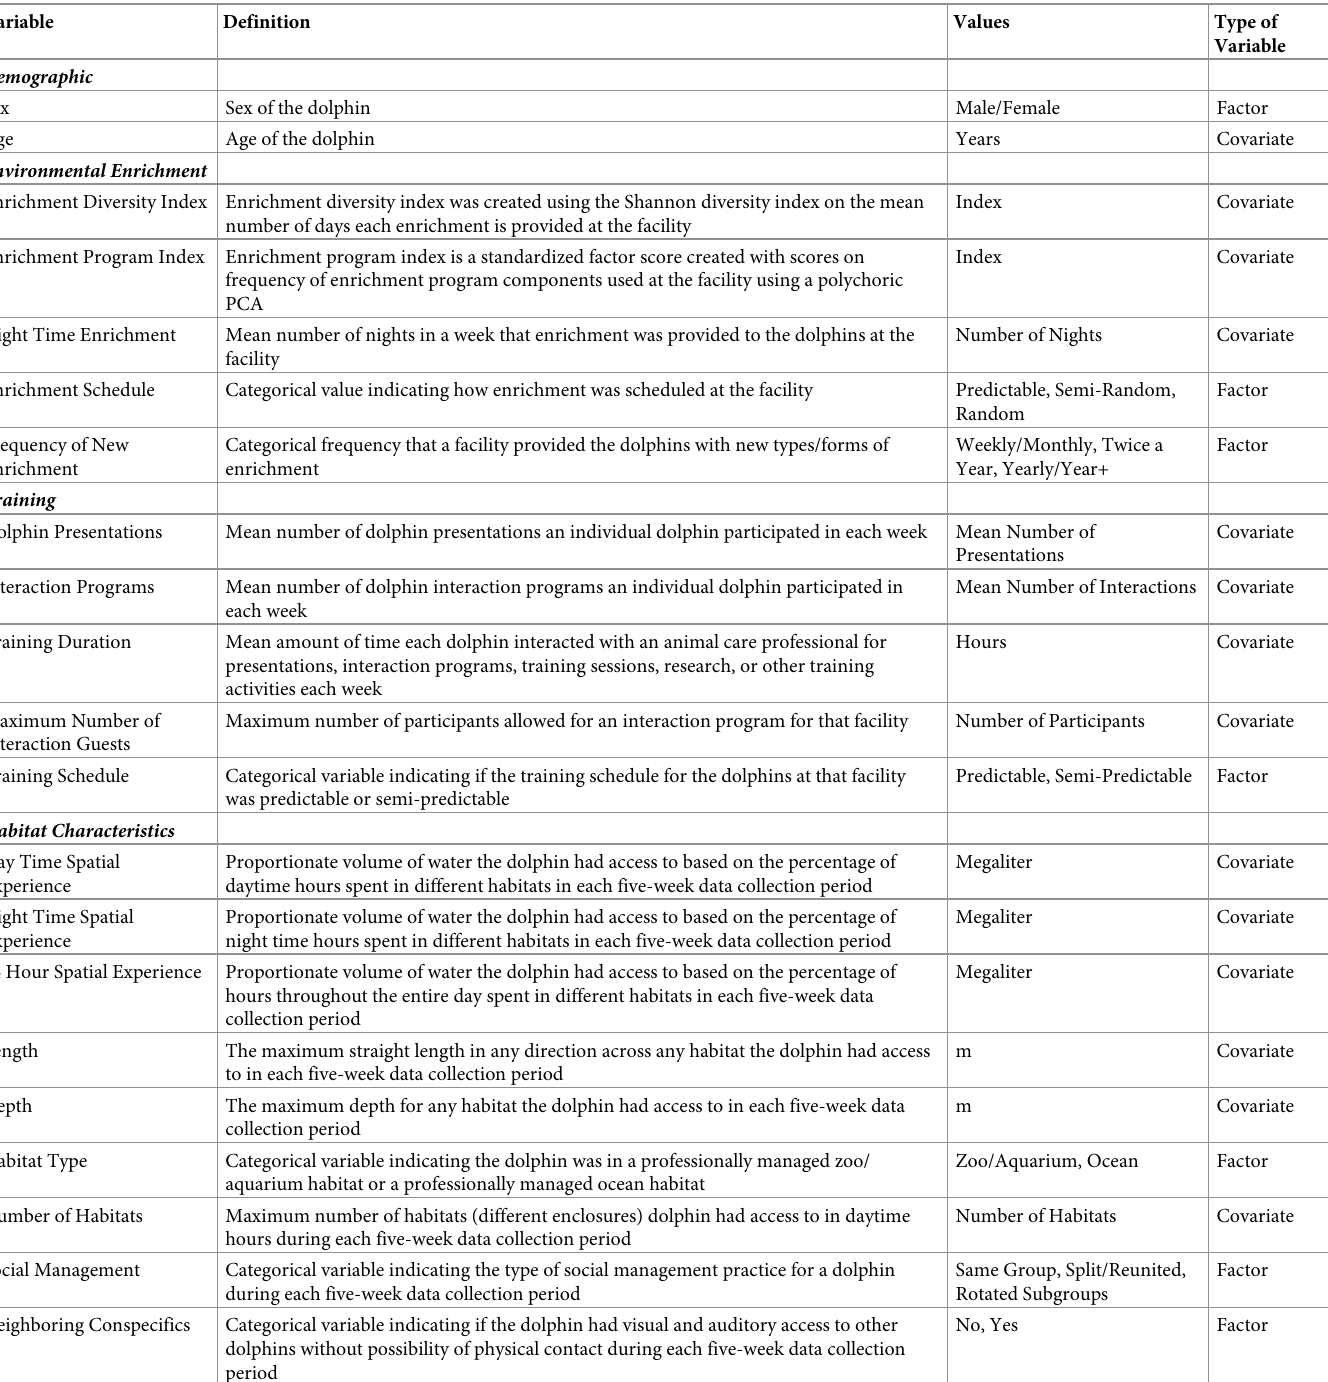
Table 1. Independent variables created from the management survey and training